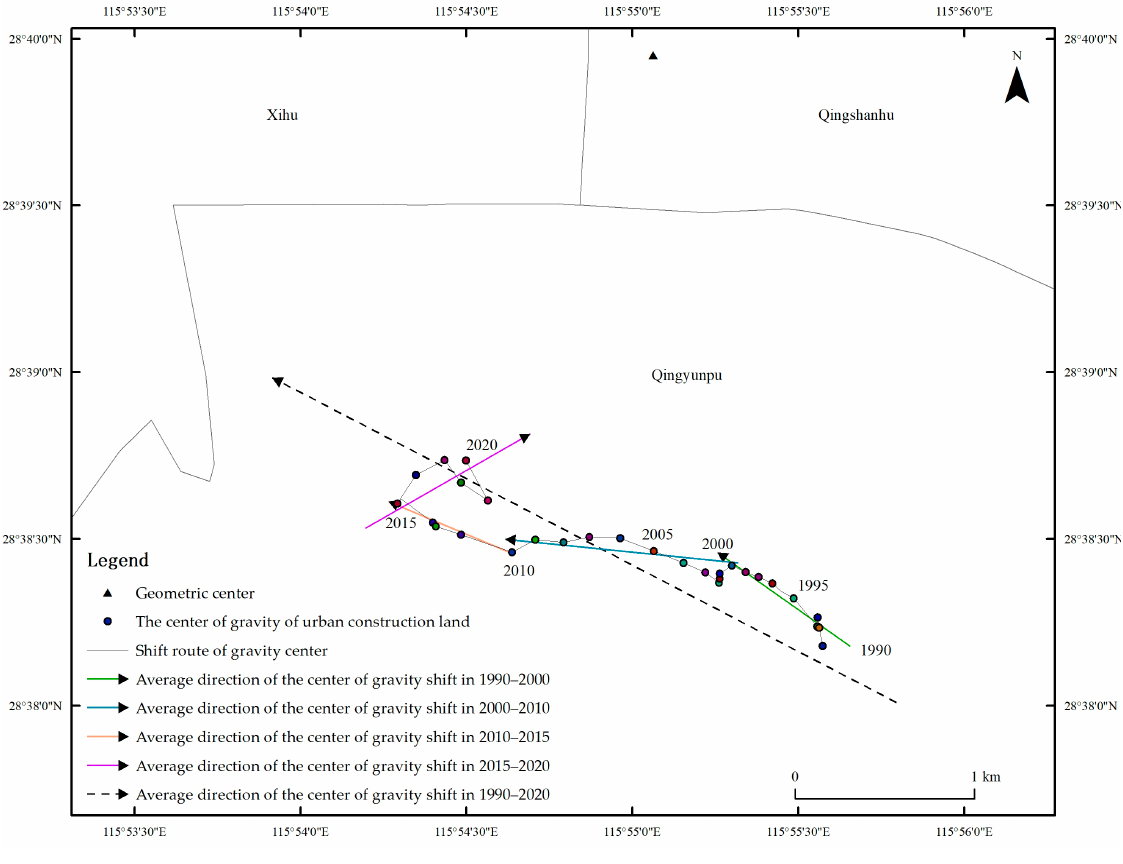
Figure 6. The shift trajectory of the center of gravity of construction land in Nanchang from 1990 to 2020.